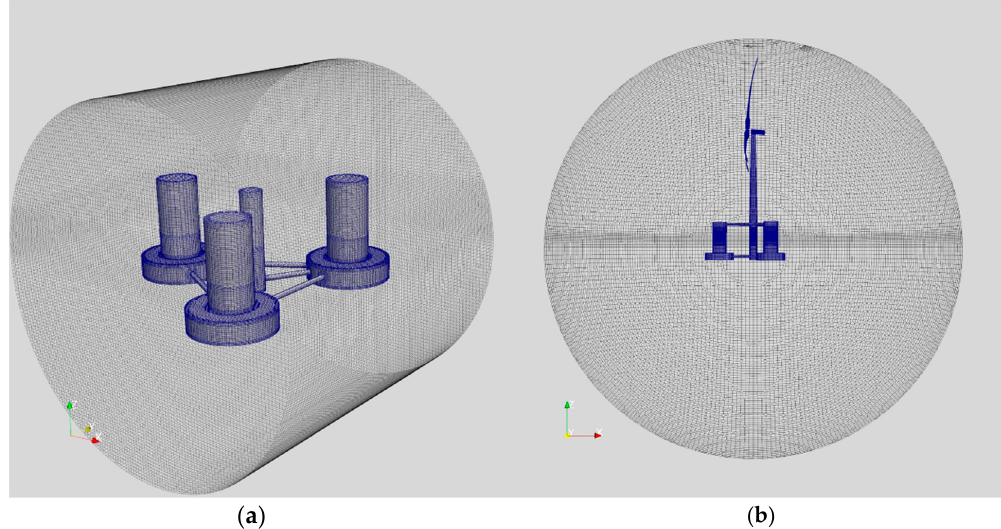
Figure 5. Computational mesh: ( a ) semi-submersible platform; ( b ) floating offshore wind turbine.